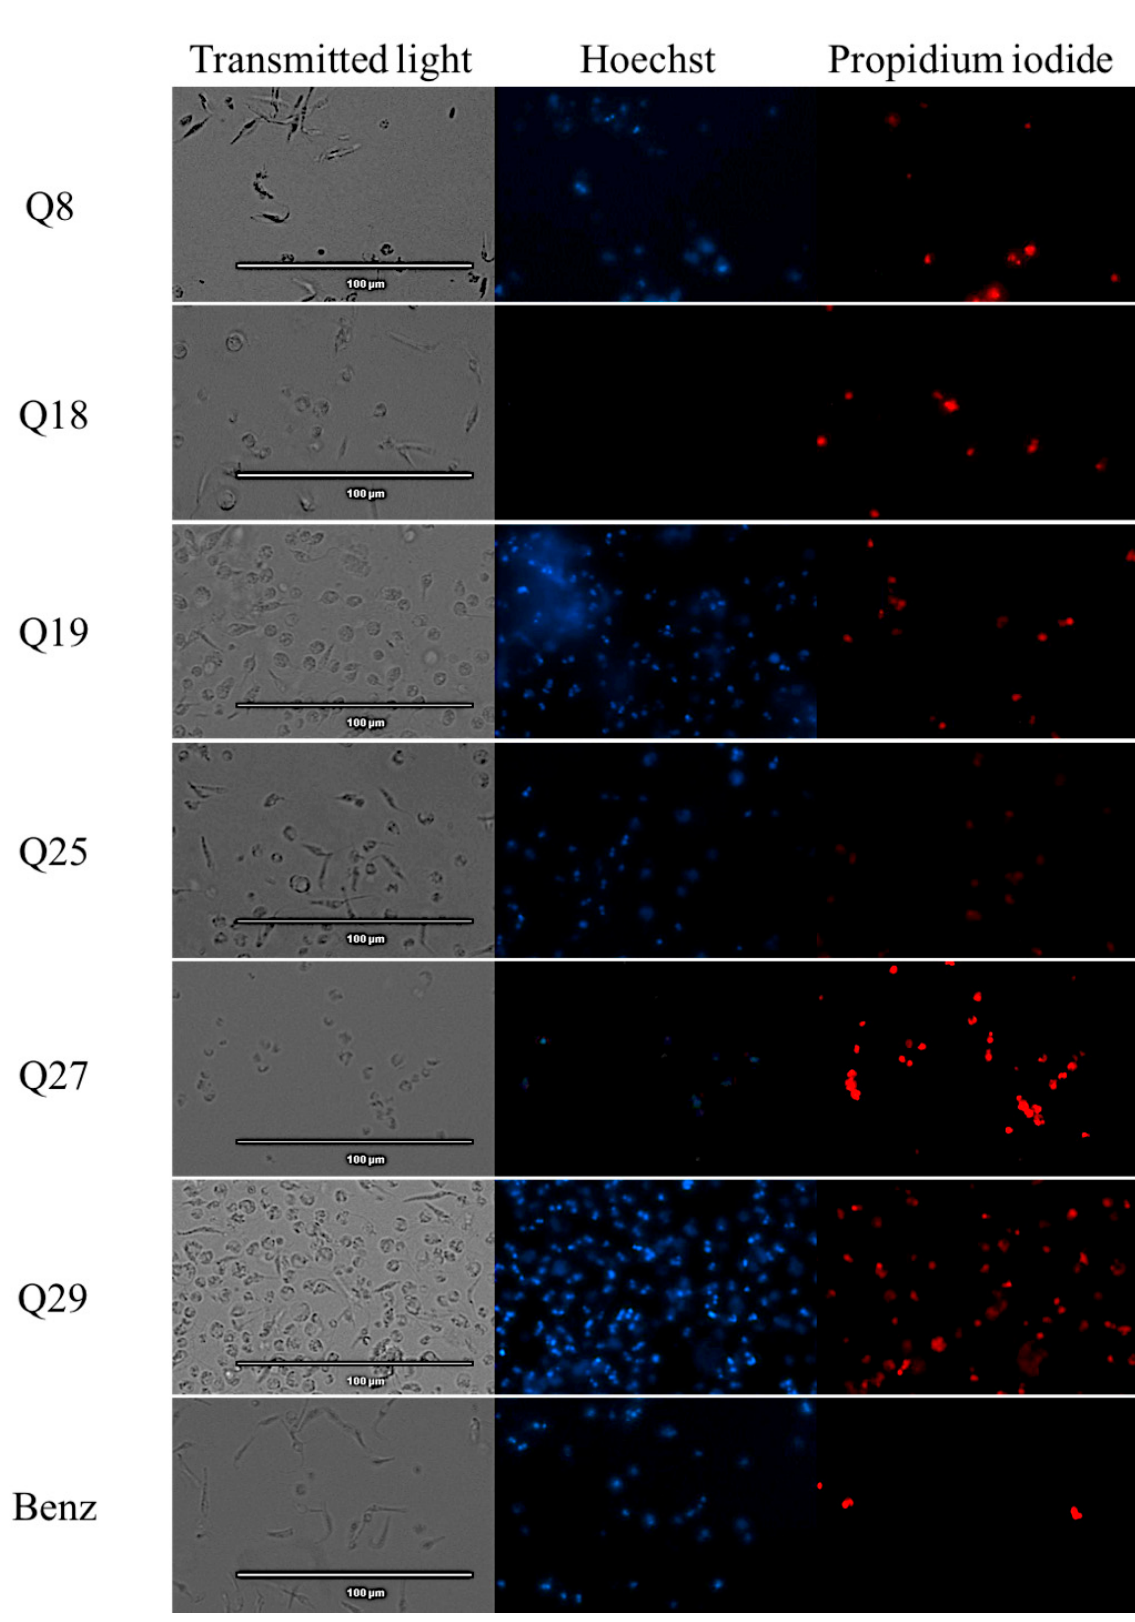
Figure 1. Detection of chromatin condensation using Hoechst–propidium iodide staining in treated parasites. Results after 24 h of incubation of epimastigotes against the IC 90 of acrylonitriles. Images were captured using an EVOS FL Cell Imaging System (40×). Scale-bar : 100 µm. Benz: benznidazole.